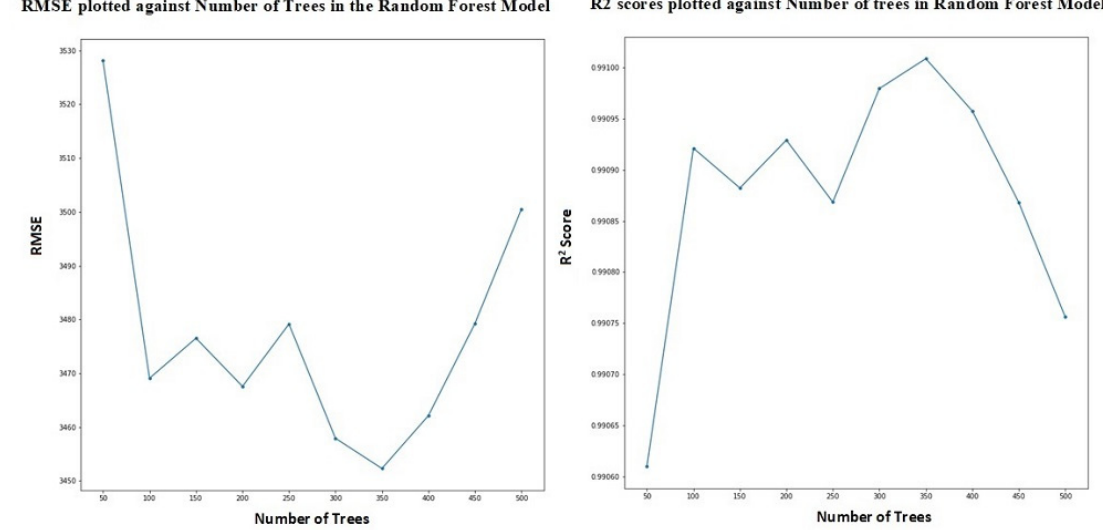
Figure 8. RMSE and R 2 plotted against number of trees in random forest model.